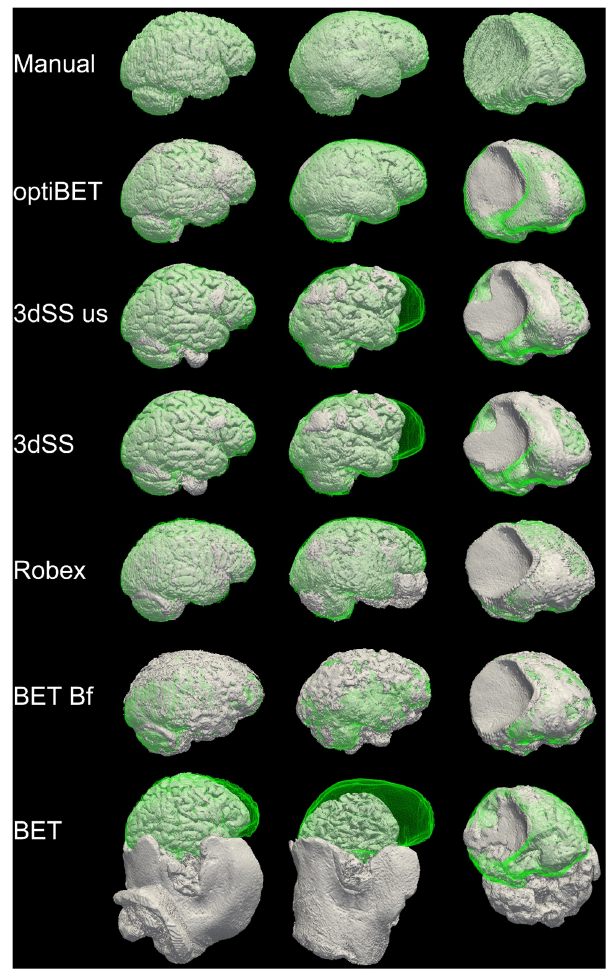
Fig. 2. Sample extraction results. Rendering of brain extractions obtained from different algorithms/options (shown in grey) compared to the manually-traced benchmark (shown in green wireframe) for three sample patients with different degrees of brain pathology (little, medium, and high, for the left, middle and right columns respectively; see Fig. 3). The first row depicts the rendering of the benchmark volume (in grey) and the benchmark wireframe to illustrate a case of ‘‘perfect fit’’. (Renderings obtained with ParaView [19]).